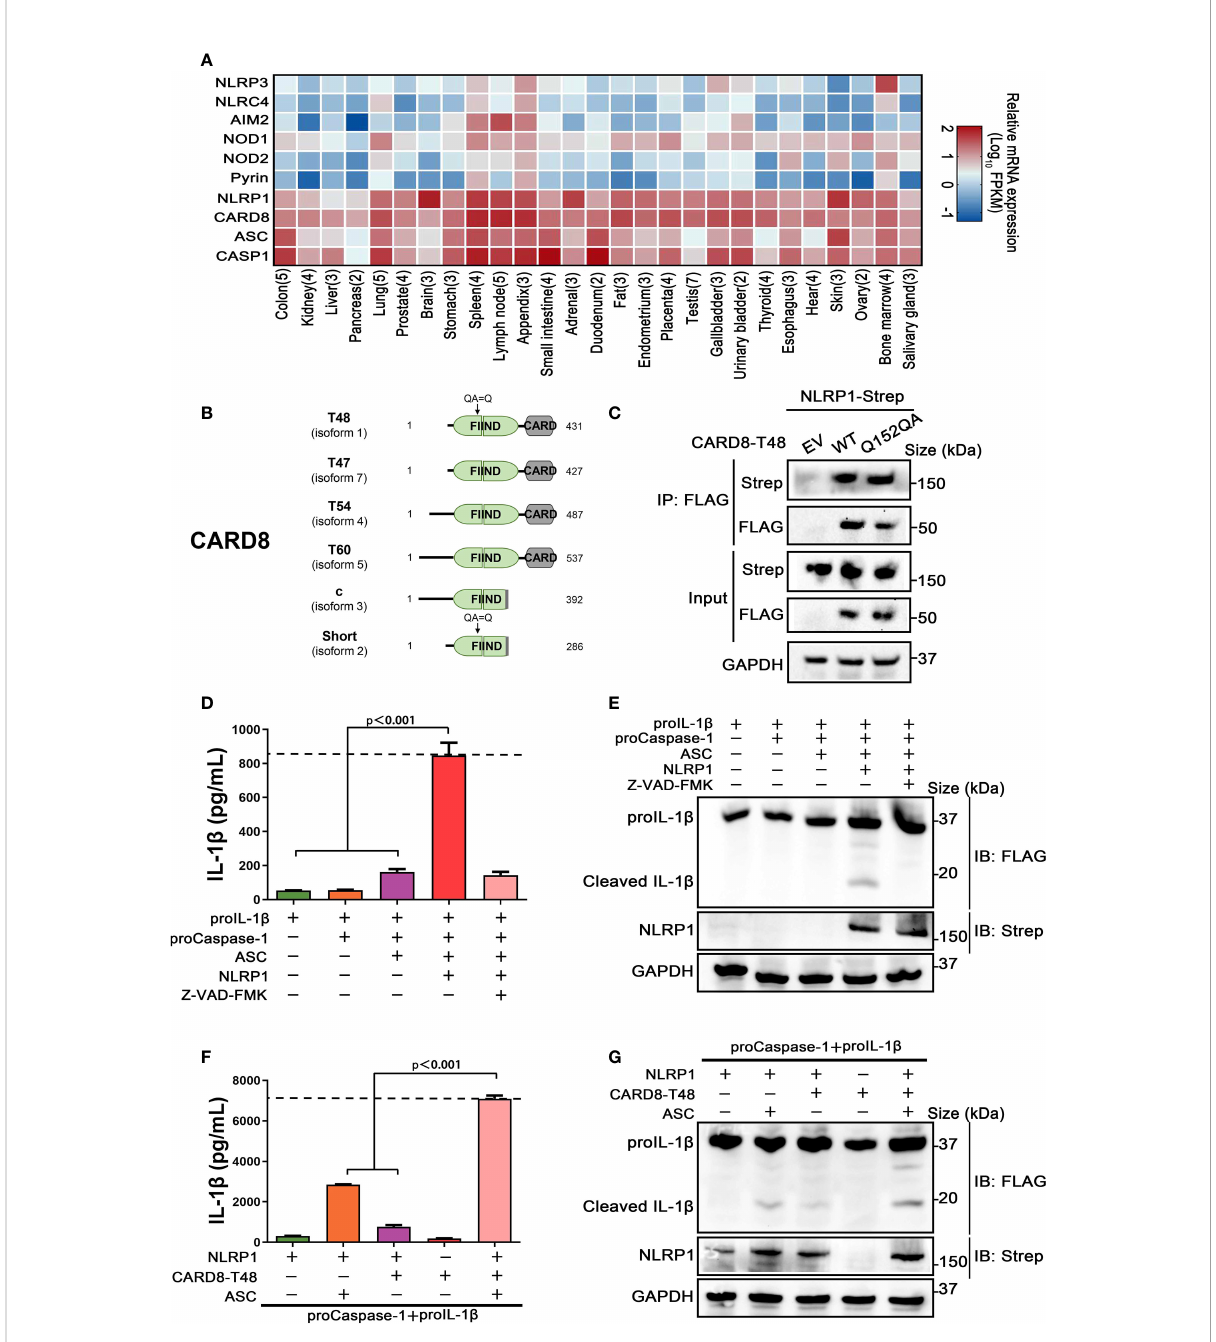
FIGURE 1 CARD8-T48 isoform interacts with NLRP1, but it does not inhibit NLRP1 activation. (A) Heat map of NLRP1 and other in fl ammasome sensors transcription expression levels in 27 kinds of tissues or organs in human body. The numbers of replicate samples are labeled in parentheses. (B) Diagram of human CARD8 different isoforms. Full-length CARD8 protein consists of a variable aminoterminal disordered region, FIIND and CARD domain. (C) HEK 293T cells were transiently transfected with constructs for empty vector (EV), CARD8-T48-FLAG, CARD8-T48-Q152QA- FLAG and NLRP1-Strep. After 28 hours, the protein expression was detected by immunoblotting, and co-immunoprecipitation (IP) were conducted with anti-FLAG antibody to analyze the interaction. (D, E) HEK 293T cells were transiently transfected with constructs encoding the proIL-1 b , proCaspase-1, ASC and NLRP1. At 48 hours later, the cultural supernatants were monitored for cleaved IL-1 b by ELISA and cell lysates were evaluated by immunoblotting. Data are shown as mean ± SEM and representative of three biological replicates. (F, G) HEK 293T cells were transiently transfected with constructs encoding the proIL-1 b , proCaspase-1, ASC, NLRP1 and CARD8-T48. After 48 hours, ELISA and immunoblotting analysis were conducted with cell cultural supernatants and lysates. Data are shown as mean ± SEM and representative of three biological